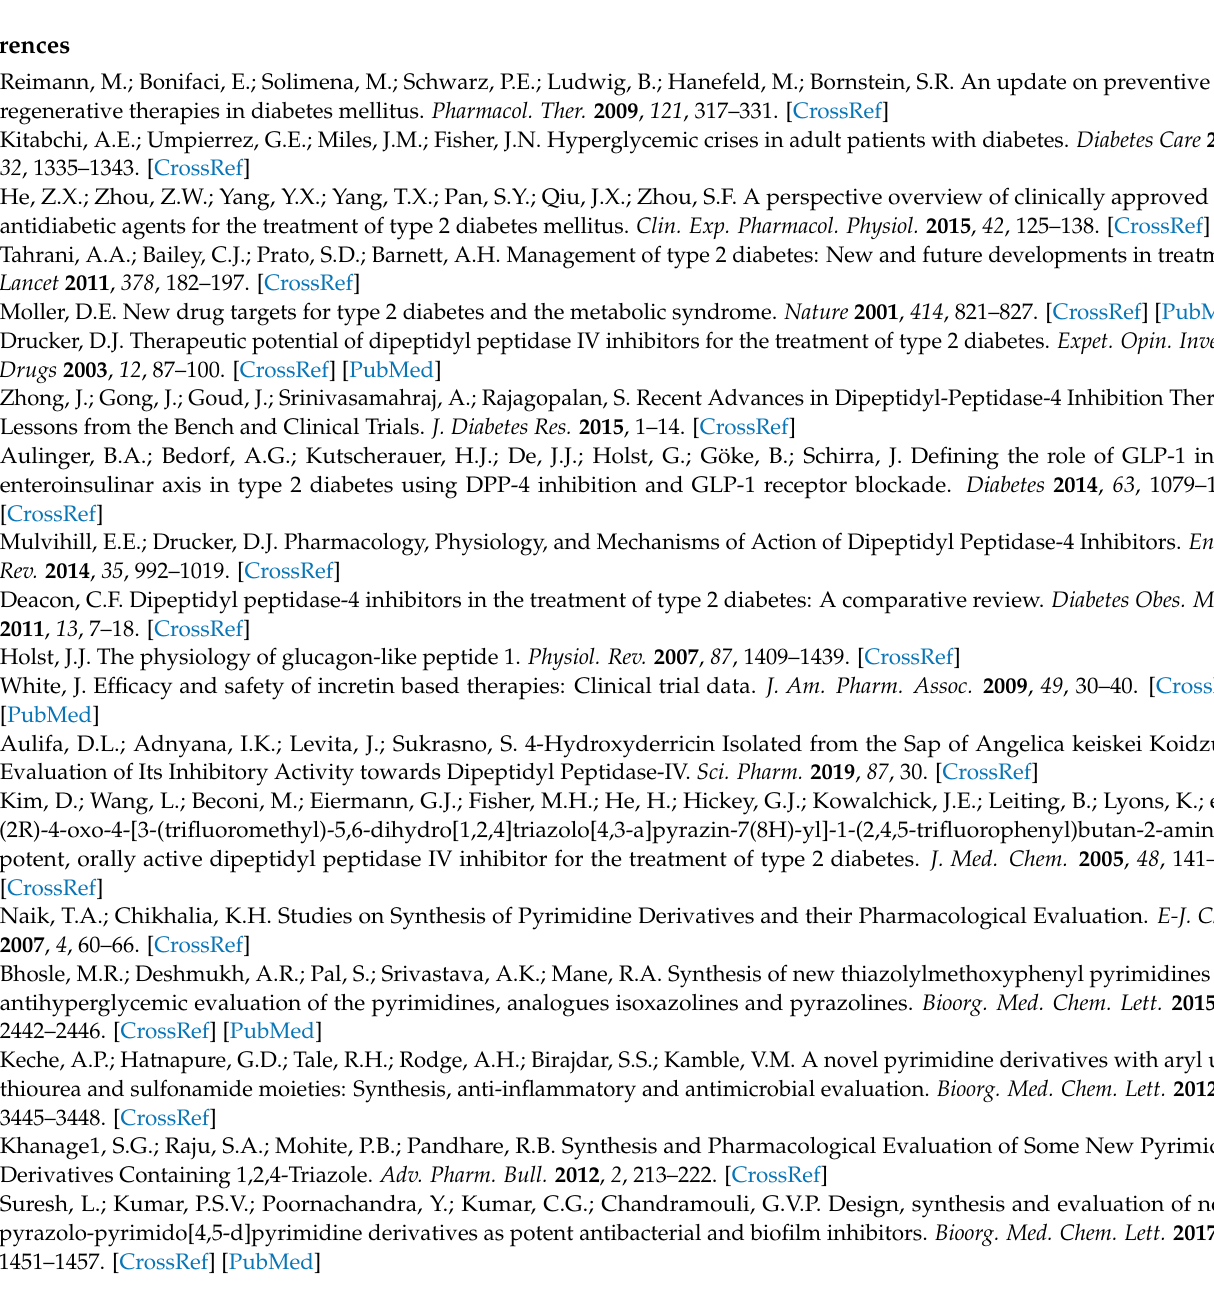
Mass Spectroscopy of Compound 10h , Figure S66: Mass Spectroscopy of Compound 10i , Figure S67: Mass Spectroscopy of Compound 10j